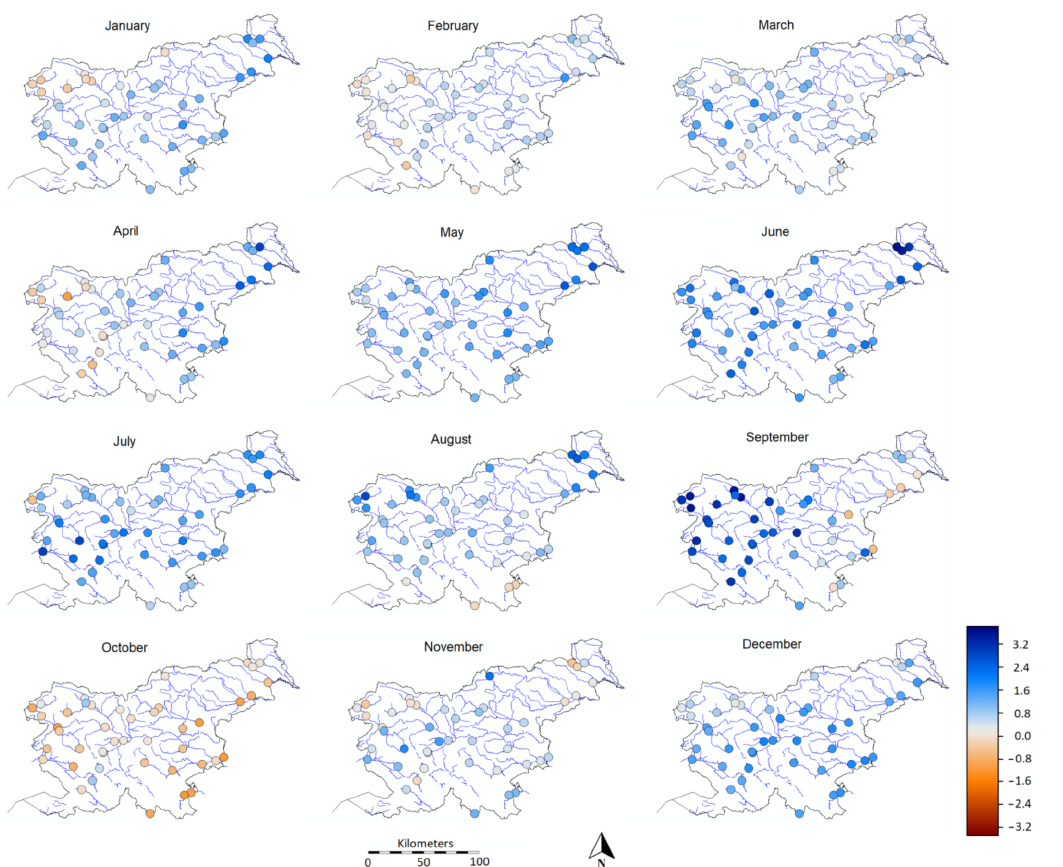
Figure 3. Spatial presentation of SSI-1 values for a wet year